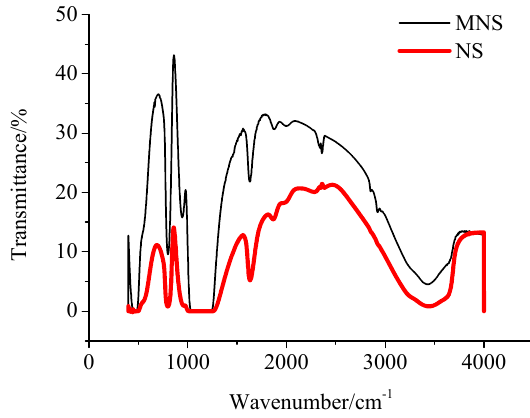
Figure 1. FITR curves for MNS and